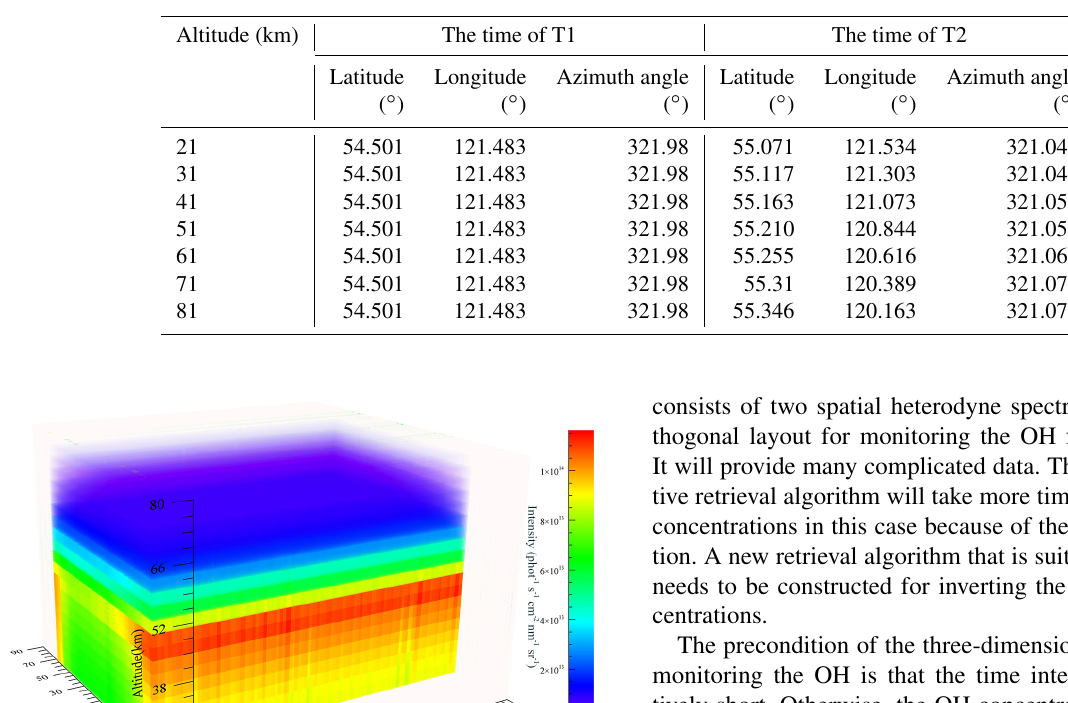
Table 4. Locations and geometry parameters of SHS1 at the time of T1 at some tangent heights and the corresponding parameters of SHS2 at the time of T2.